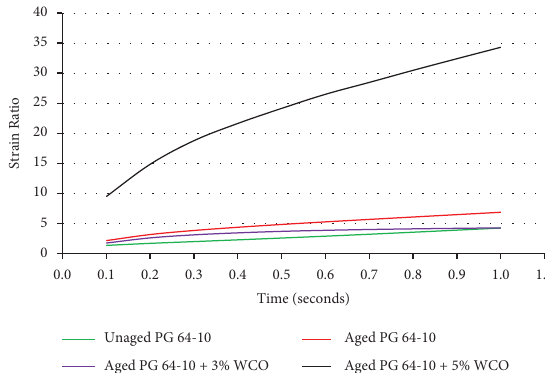
Figure 8: Strain ratio for PG 64-10